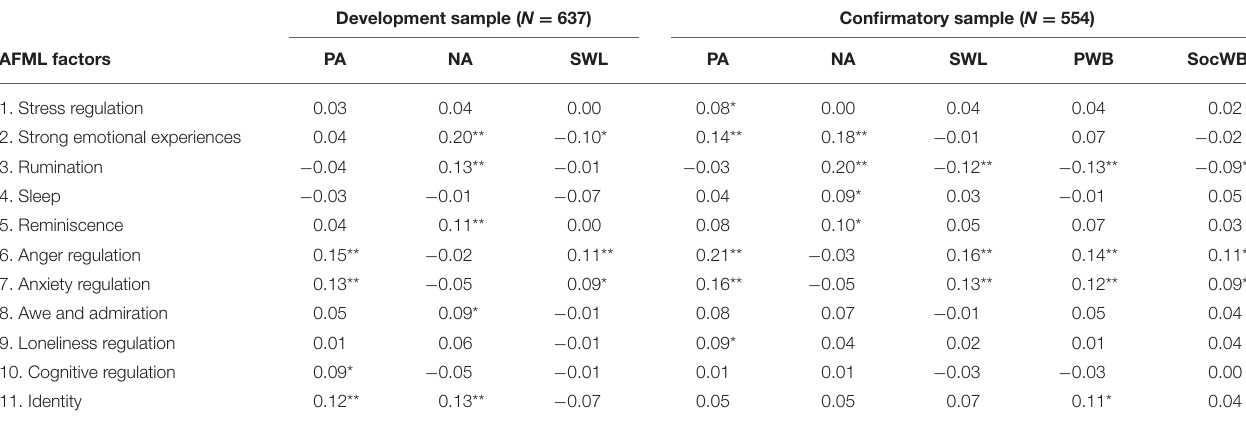
TABLE 6 | Bivariate correlations between AFML factors and wellbeing measures. Development sample ( N = 637) Confirmatory sample ( N = 554)